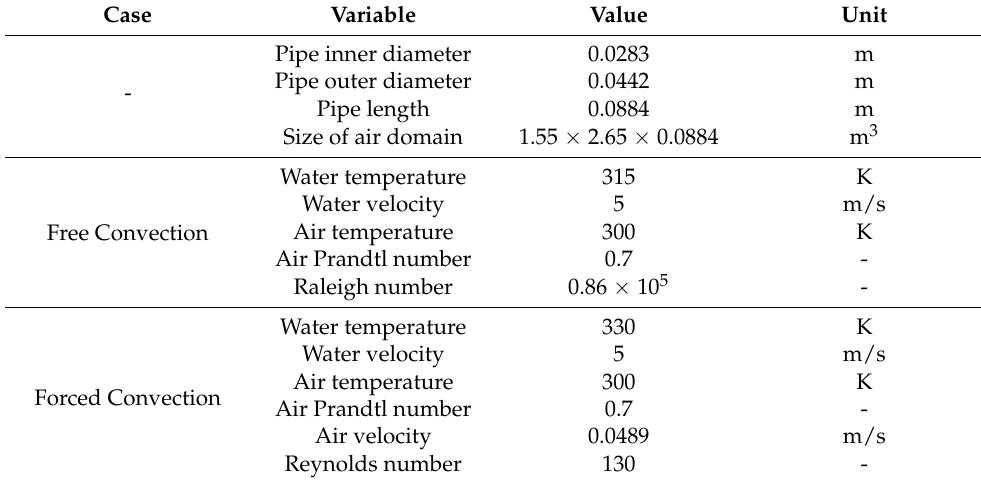
Table 1. Parameters of the pipe simulation setup.